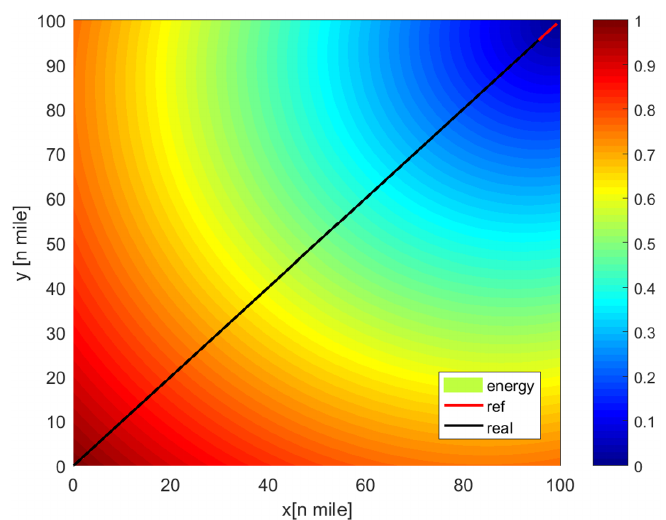
Figure 11. Variability of control.